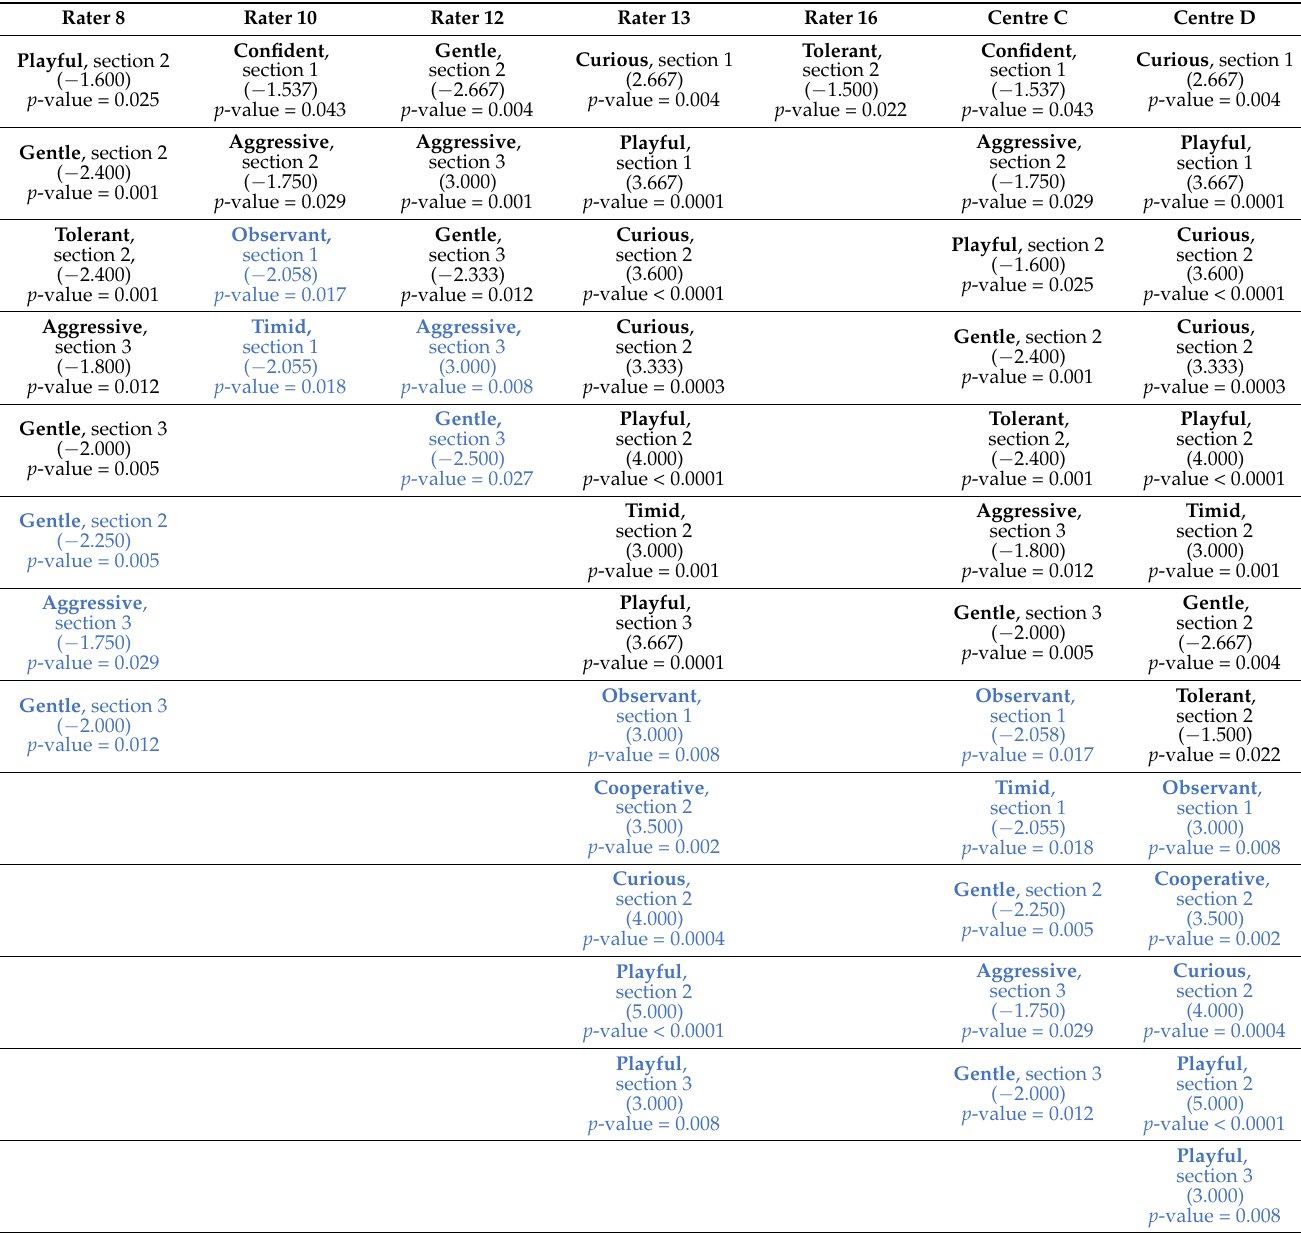
Table 5. Statistically significant (5% significance level) mean differences in scores between tests 1 and 2 for rater, centre, adjective (in bold), and sex of the dolphin. Female results in black, male results in